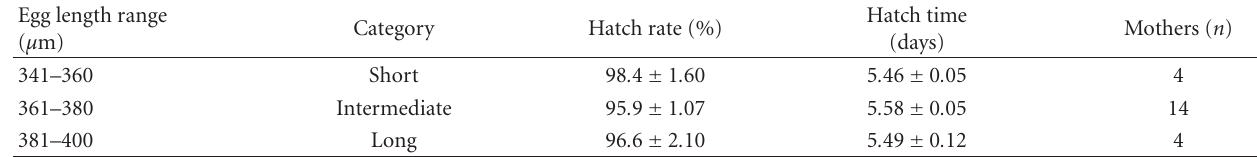
Table 2: Mean ± SEM hatch rate and hatch time of predator eggs in relation to size